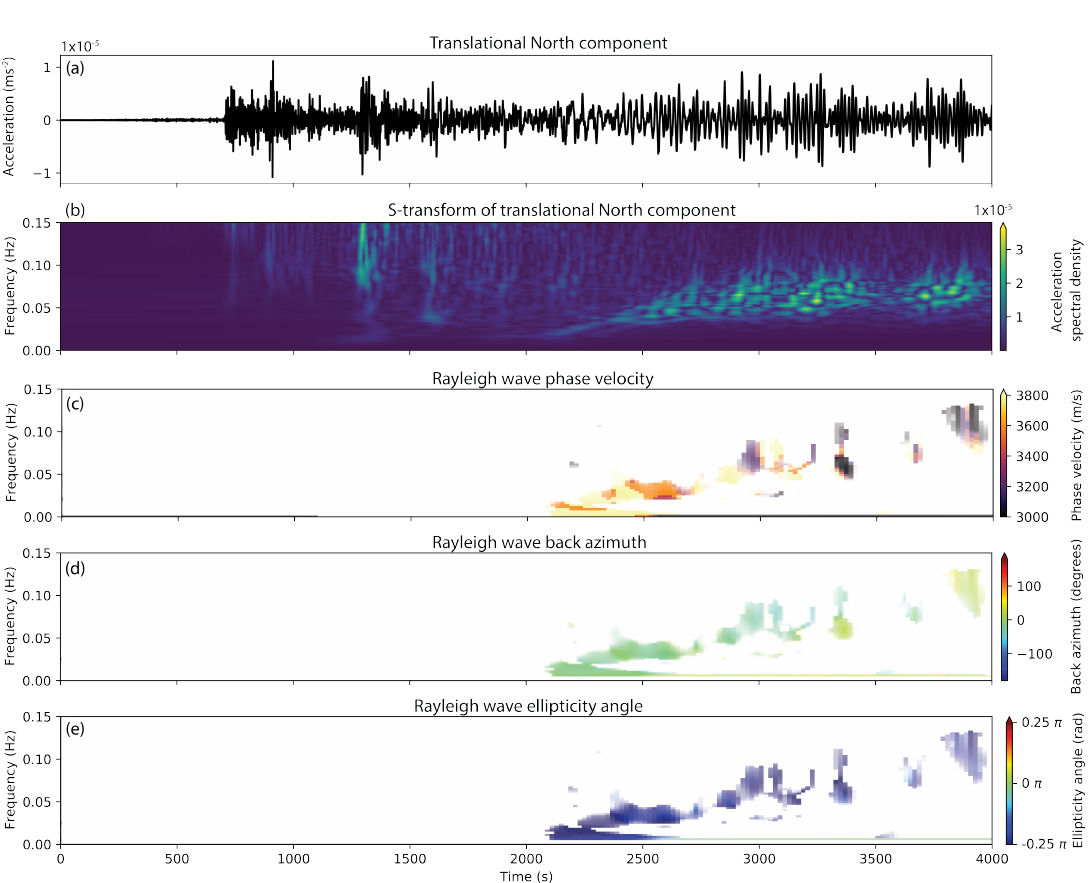
Figure 4. Single-station wave parameter estimation using 6DOF polarization analysis on the example of the 2018 gulf of alaska earthquake. The North component of translational motions is displayed in ( a ) with the corresponding S-transform in ( b ). Shown below is the estimation of frequency- and time-dependent Rayleigh wave parameters: phase velocity ( c ), back azimuth ( d ), and ellipticity angle ( e ). The results are only displayed at time-frequency pairs where the automatic detection routine identified a Rayleigh wave (Figure 5). See text for